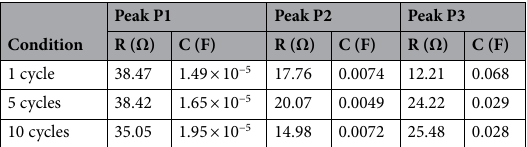
Table 1. Table for effective resistances and capacitances calculated from the DRTs of Fig. 4.